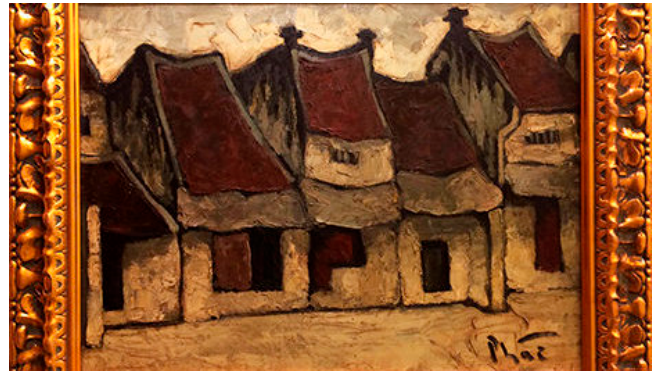
Figure A13. Pho Co Ha Noi— Bui Xuan Phai. Philanthropy auction, October 2016. The images were sourced from Tuoi Tre Newspaper (Thi 2016).